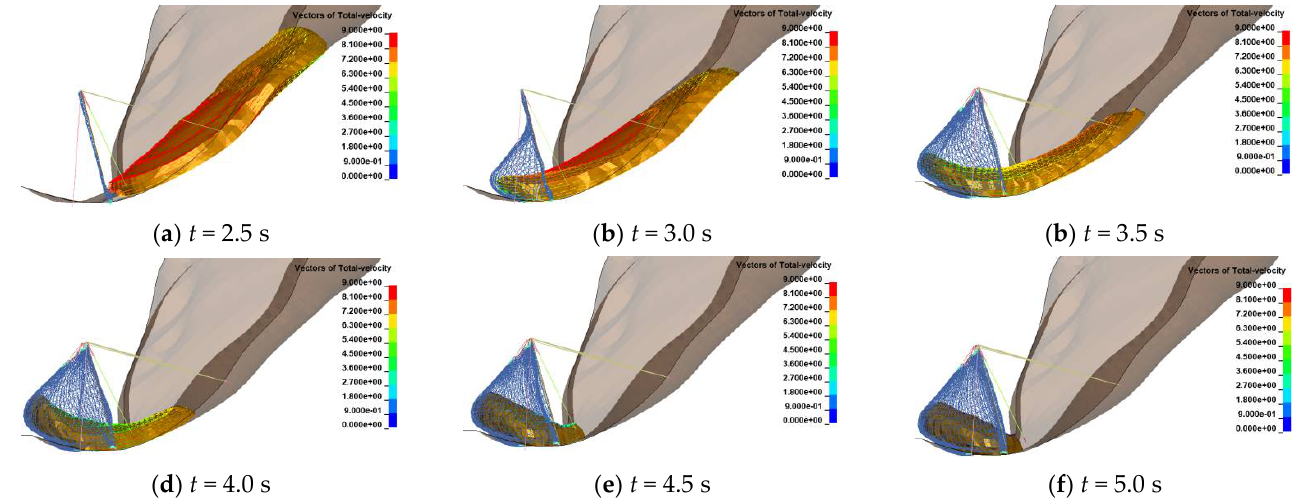
Figure 8. Typical moments of the interception process.